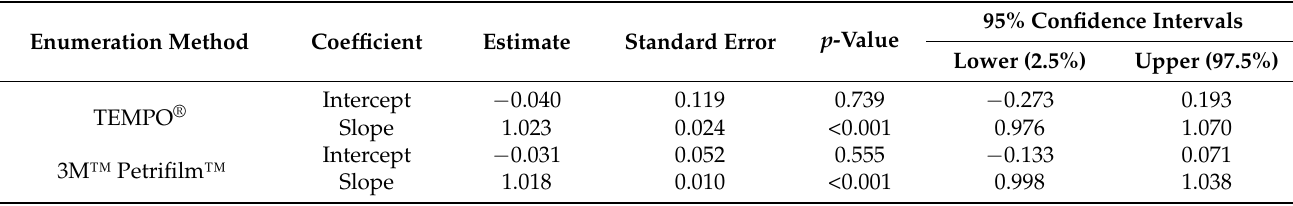
Table 3. Summary table of linear models using the least squares regression method predicting the bacterial counts of 3M™ Petrifilm™ and TEMPO ® when compared with with the standard method (direct